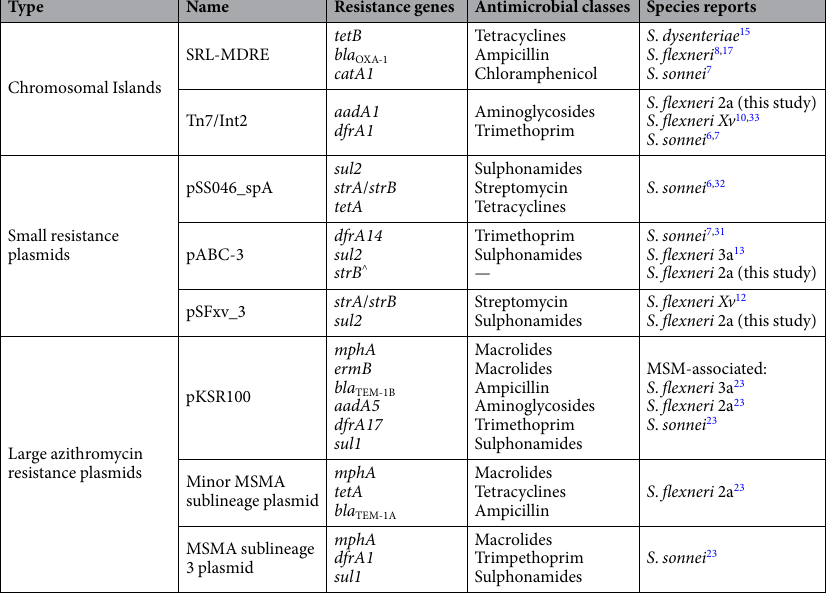
Table 1. Antimicrobial resistance determinants of Shigella and species distributions. ^ The strA gene has been interrupted by the introduction of dfra14 on this plasmid meaning no Streptomycin resistance would be